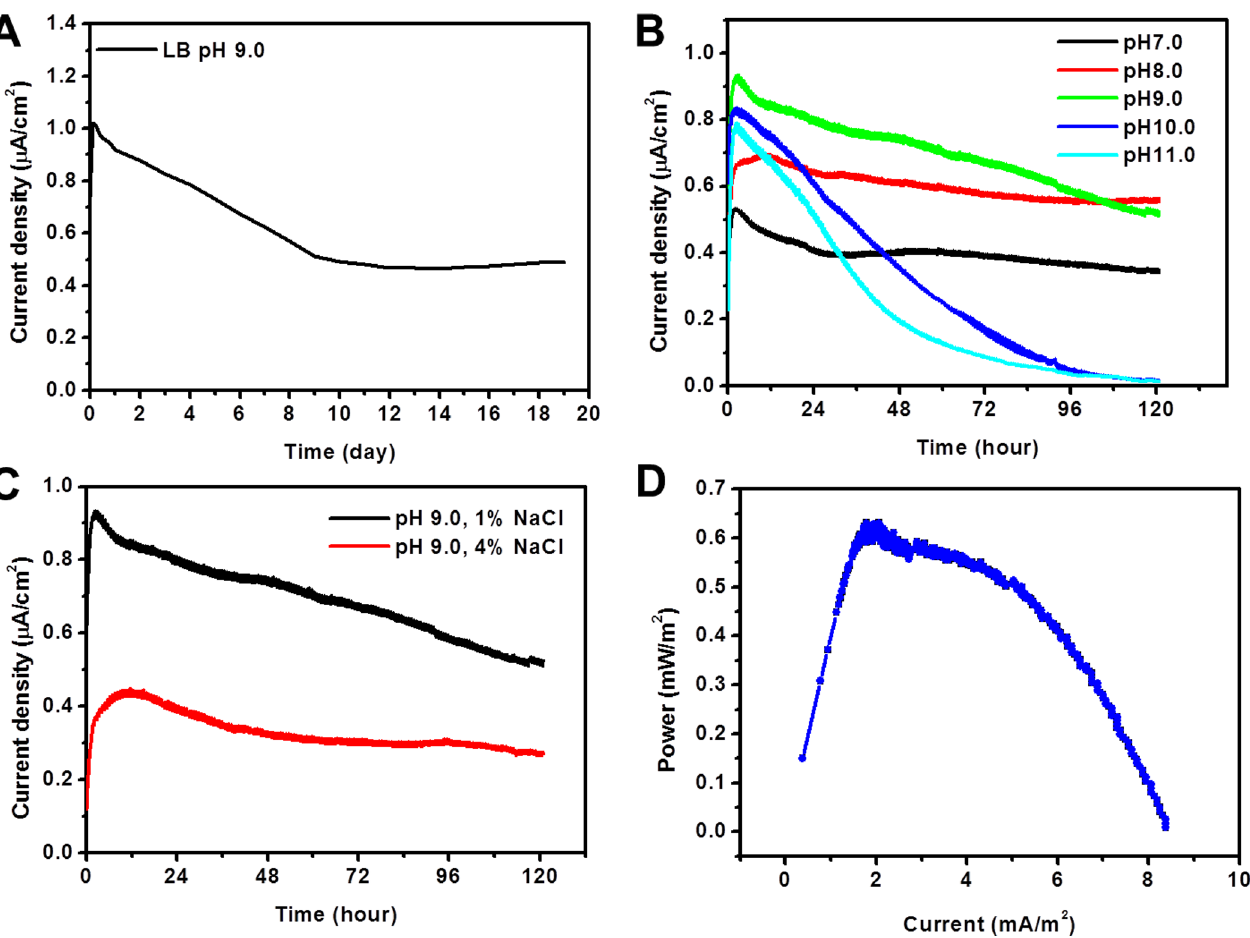
Fig 4. Bioelectricity generation by MFCs inoculated with A . andensis ANESC-S T operated under different pH and salt concentrations. (A) Current density vs. time plot of A . andensis ANESC-S T in LB broth (pH = 9.0, 1% NaCl). (B) Current density vs. time plot of A . andensis ANESC-S T in LB broth with pH 7.0, 8.0, 9.0, 10.0, and 11.0. (C) Current density vs. time plot of A . andensis ANESC-S T in LB broth with 1% and 4% NaCl. Data represents an average of triplicates. (D) Power density curve of the MFC inoculated with A . andensis ANESC-S T in LB broth (pH 9 and 1%